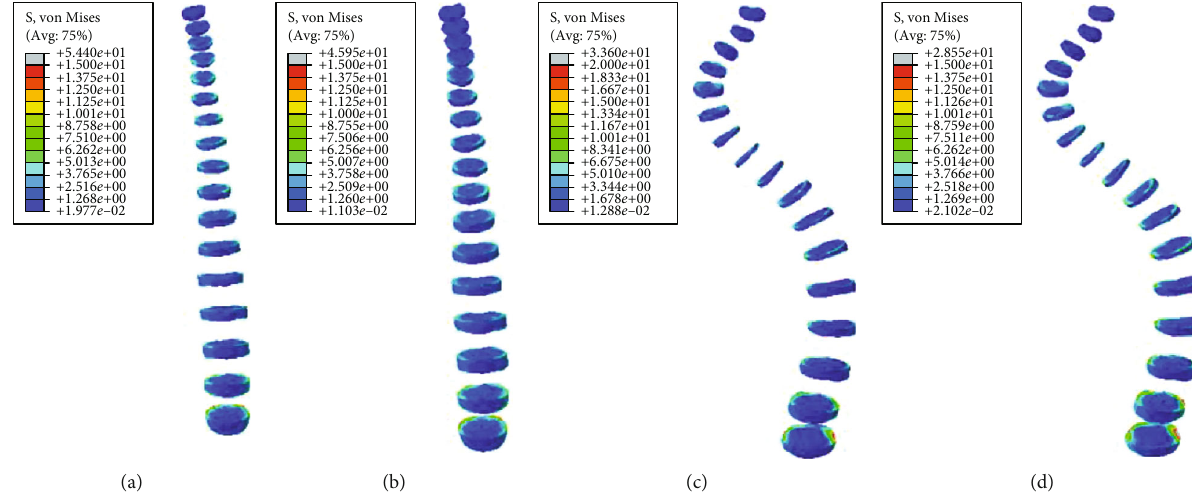
Figure 6: von Mises stress distribution of discs in four spinal models with right curvature: (a) normal spine without rib cage (NS1); (b) normal spine with normal rib cage (NS2); (c) scoliotic spine without rib cage (SS1); (d) scoliotic spine with deformed rib cage (SS2).